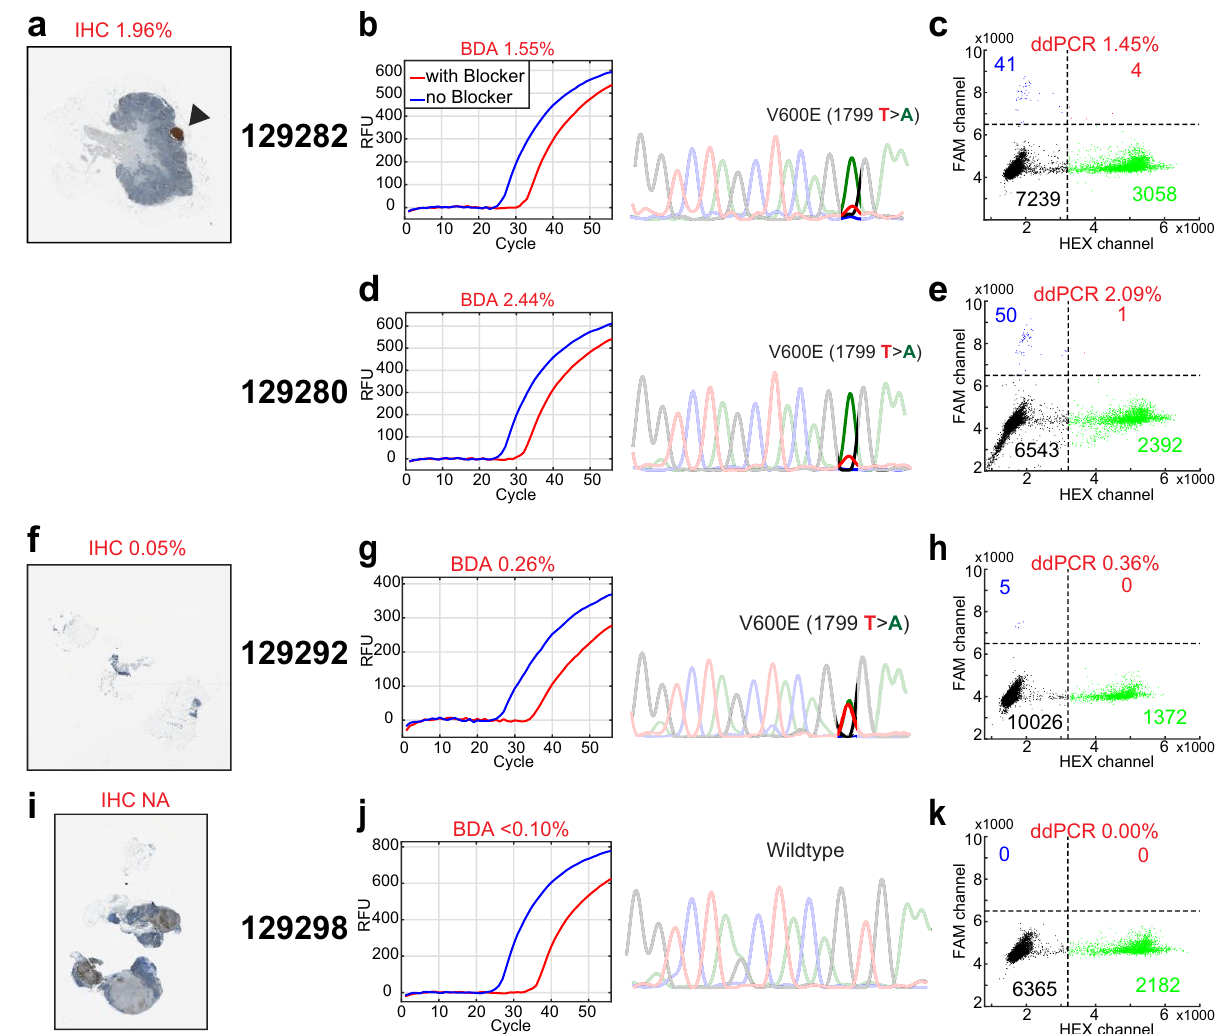
Figure 2. Comparative analytical results for select FFPE clinical samples. ( a ) IHC anti-BRAF V600E stained tissue from patient 1. Stained tumor exhibited brown color as pointed by the arrowhead. ( b , c ) Results for non- macrodissected patient 1 sample 129282, including BDA qPCR curves, Sanger sequencing trace(b) and ddPCR scatter plot(c). ( d , e ) Results for macrodissected patient 1 sample 129280. ( f – h ) IHC, BDA Sanger, and ddPCR results for patient 4 sample 129292. ( i – k ) IHC, BDA Sanger, and ddPCR results for patient 6 sample 129298. Red qPCR curve showed amplification of BDA reaction with blocker for variant enrichment, and blue curve showed amplification of control reaction that did not contain blocker. The position of variant peak is highlighted in Sanger trace. In ddPCR scatter plots, the lower left quadrant showed empty droplets. The lower right quadrant showed droplets containing WT molecules. The upper left quadrant displayed droplets containing variant molecules. The upper right quadrant exhibited droplets containing both WT and variant